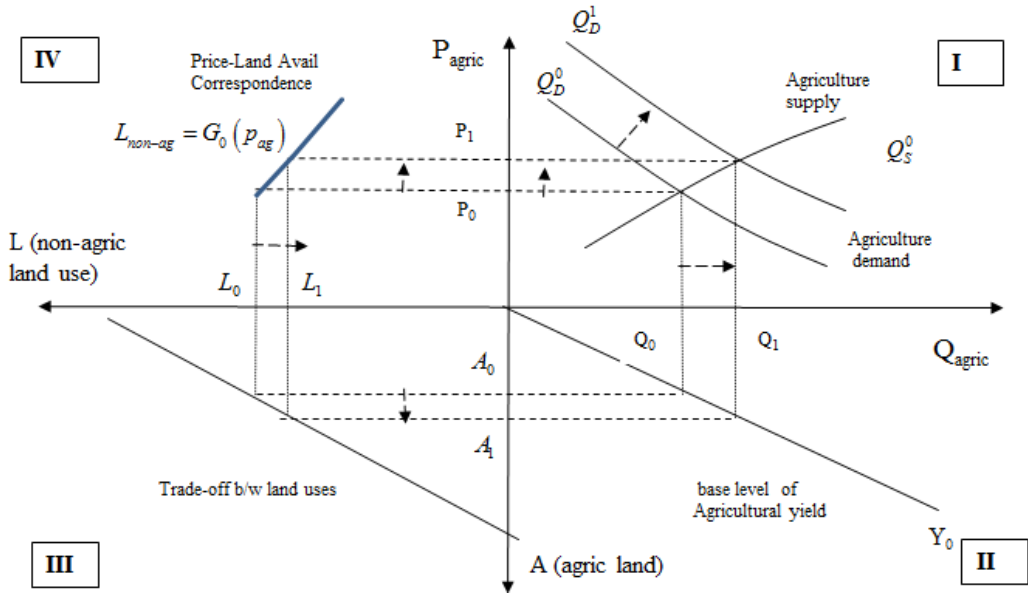
Figure 1. Linkages between biofuel-driven market shifts and agricultural land use in base